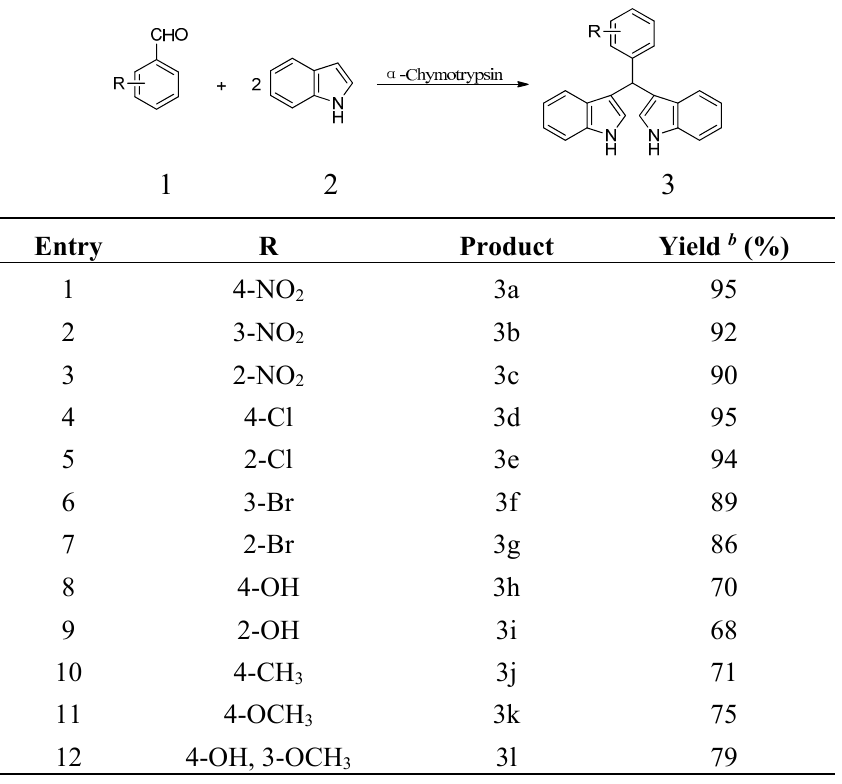
Table 2. Investigation of the reactant scope of the α -chymotrypsin-catalyzed cascade reaction a